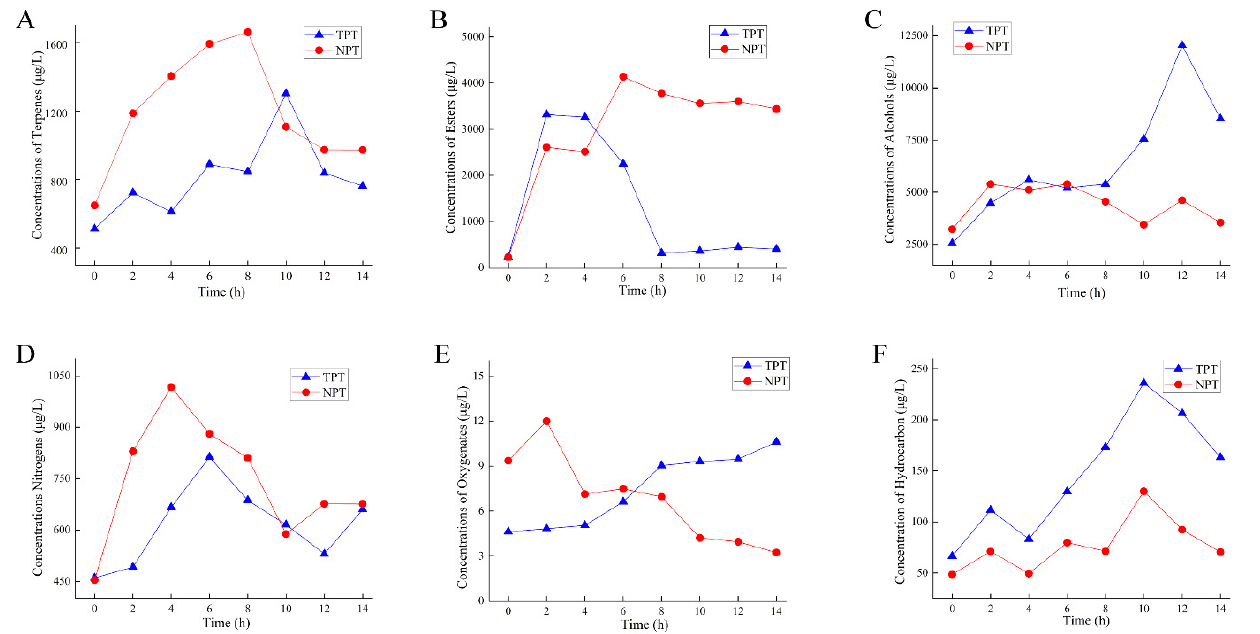
Figure 9. Changes in the main aromatic substances of jasmine tea during scenting. ( A ) terpenes. ( B ) ( B ) esters. ( C ) alcohols. ( D ) nitrogens. ( E ) oxygenates. ( F ) esters. ( C ) alcohols. ( D ) nitrogens. ( E ) oxygenates. ( F ) hydrocarbons.